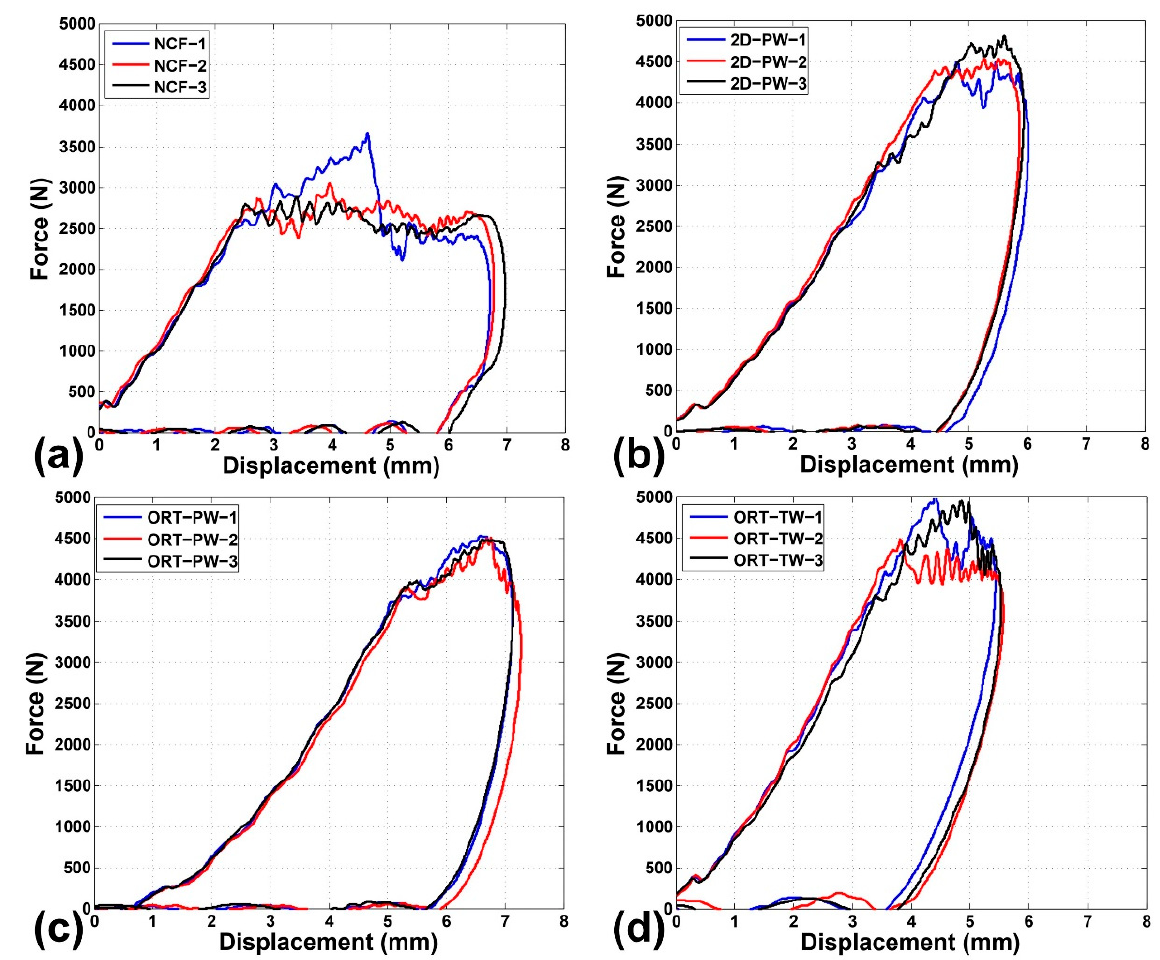
Figure 4. Impact force–displacement curves for the impacted specimens: ( a ) NCF, ( b ) 2D-PW, ( c ) ORT-PW and ( d ) ORT- TW.